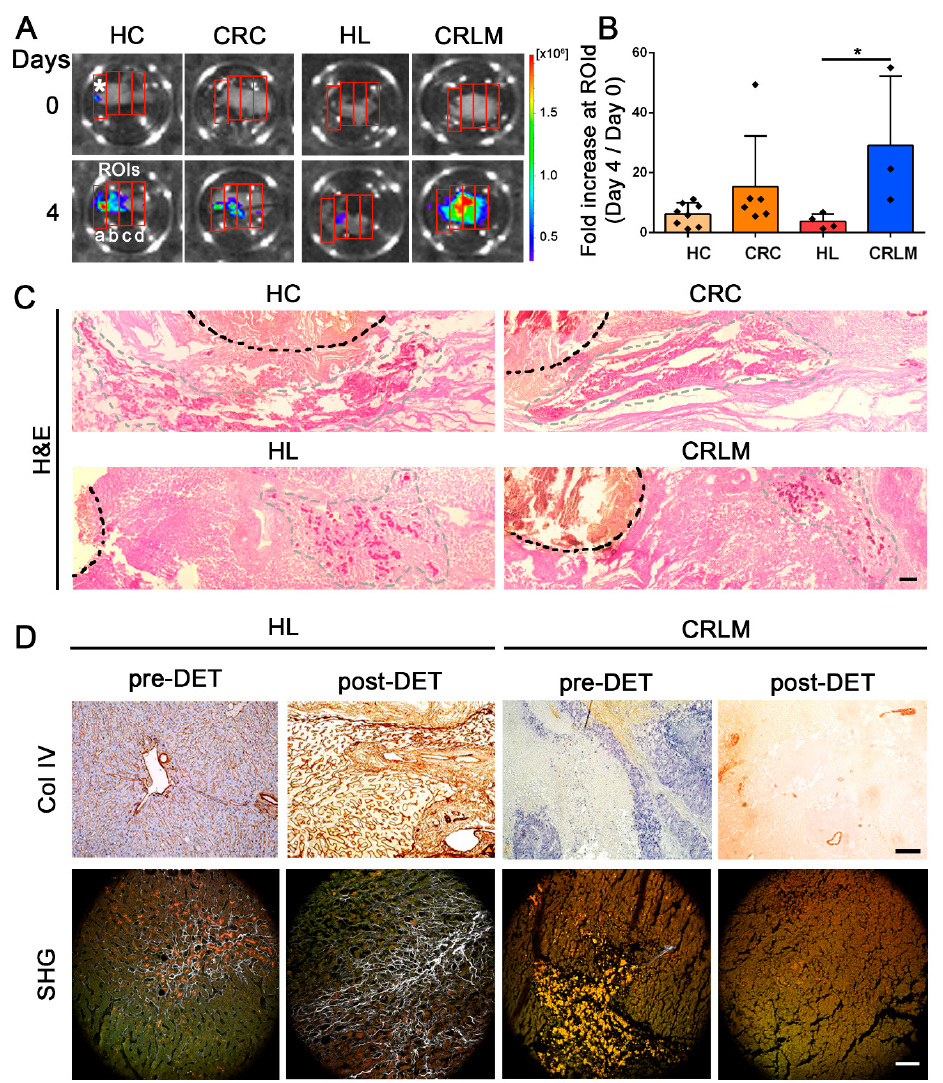
Figure 3. Migration analysis of recellularized CRC and CRLM scaffolds and collagen distribution. ( A ) Representative bioluminescence pictures show the migration rate of HT-29 cells seeded in healthy (HC and HL) and neoplastic decellularized scaffolds (CRC and CRLM) from day 0 to day 4. Asterisk: HT-29 cell injection point. a, b, c, d, and red rectangles: regions of interest (ROIs). ( B ) Bar graph summarizes the migration rate of HT-29-recellularized scaffolds (HC, n = 3; CRC, n = 3; HL, n = 4; CRLM, n = 3). Cell migration was calculated as the fold increase in ROI d between day 0 and day 4. ( C ) Representative H&E images at day 4 show the injection site of HT-29 cells in each scaffold (black dotted line) and the differential cell migration ability (migration front highlighted with a gray dotted line). Scale bar: 100 µm. ( D ) Top: Collagen IV (Col IV) immunohistochemistry of normal (pre-DET) and decellularized (post-DET) tissue samples of HL and CRLM. Scale bar: 100 µm. Bottom: second-harmonic generation images (SHG) of pre-DET and post-DET tissue samples of HL and CRLM. Collagen I in SHG images is highlighted in white, nuclei in light orange, and lipofuscin granules in dark orange. Scale bar: 100 µm. * p -value < 0.05; by a one-way ANOVA test following Tukey's Multiple Comparison Test.